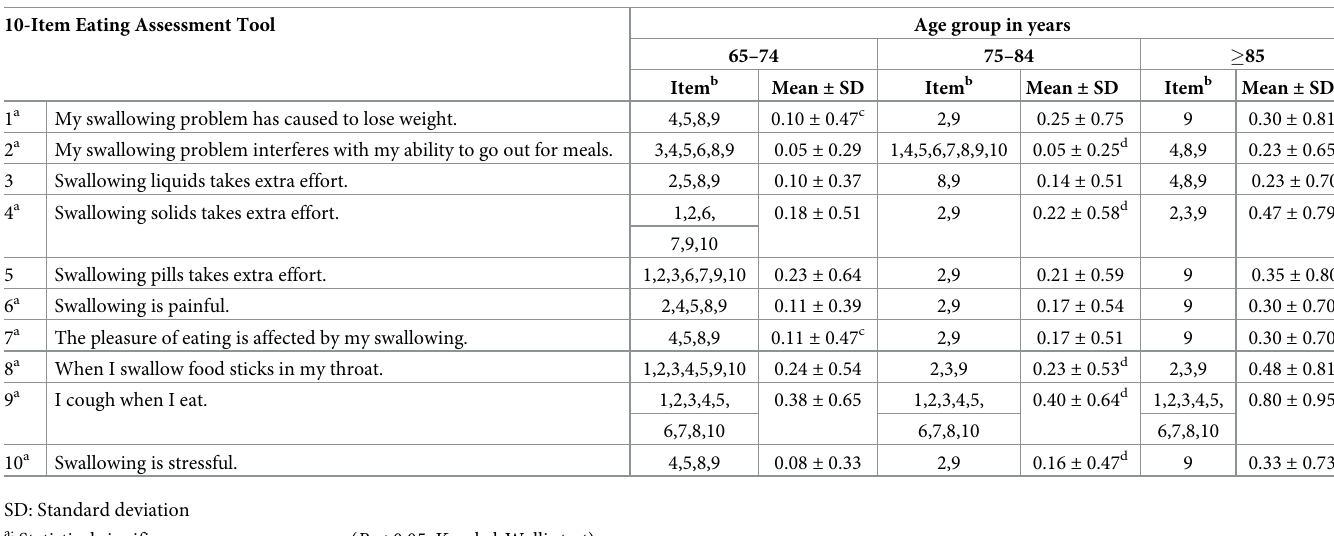
Table 5. Distribution of scores from three age groups relating to each item of the Eating Assessment Tool (EAT-10). 10-Item Eating Assessment